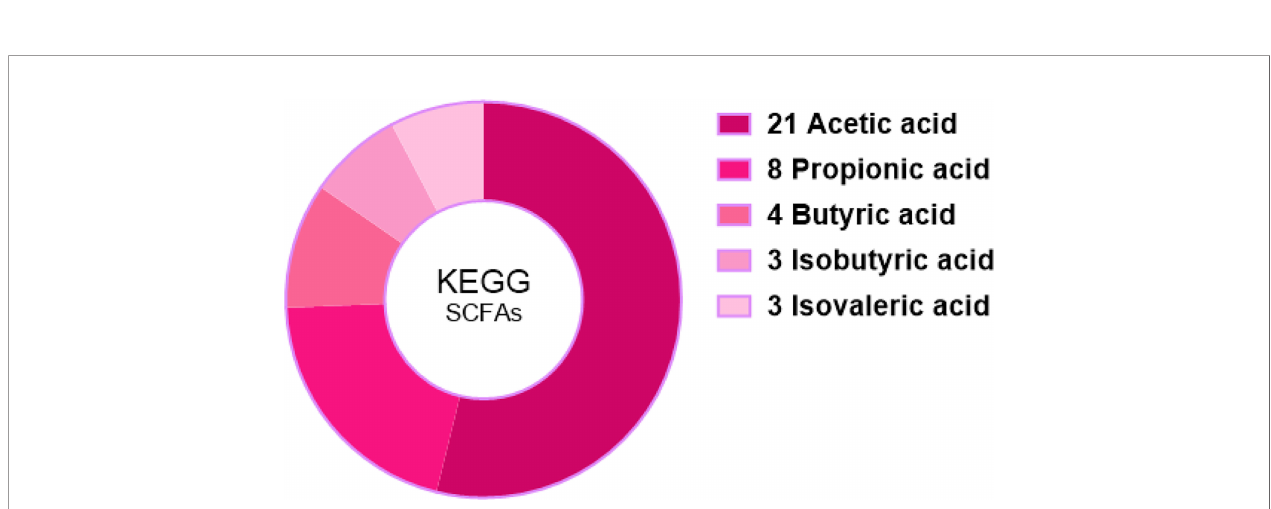
FIGURE 9 | Comparing the concentrations of SCFA in normal and diarrhea groups. The x -axis corresponds to SCFA, and the y -axis corresponds to the concentration of SCFA.